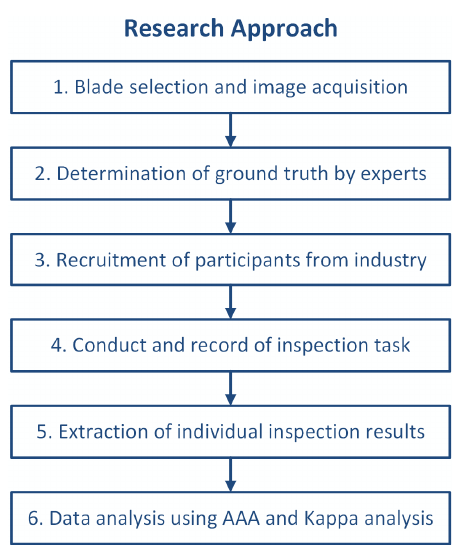
Figure 1. Research approach.